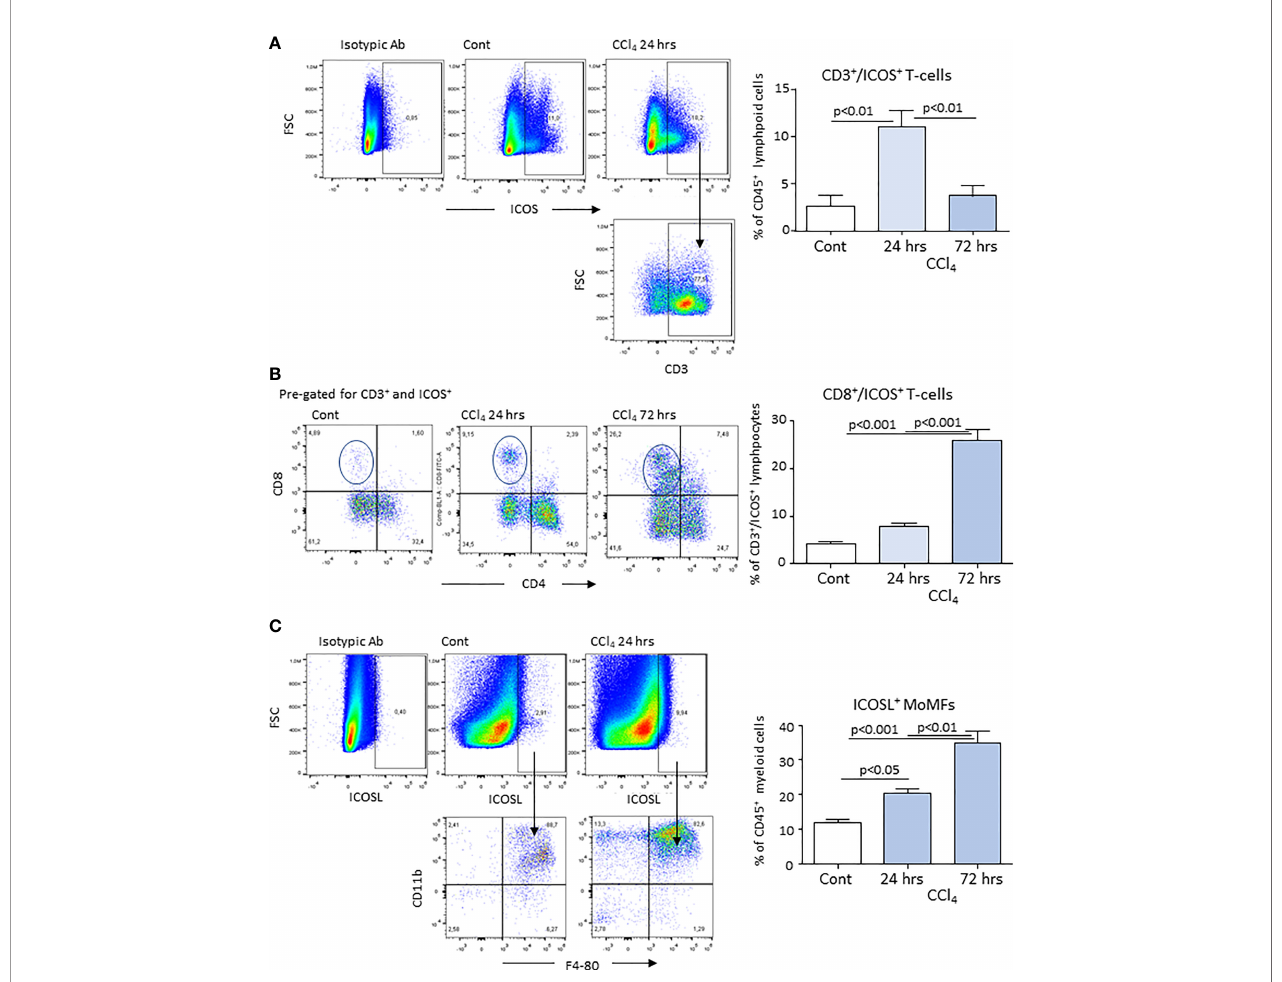
FIGURE 2 | Expression of ICOS and ICOSL by lymphocytes and monocyte-derived macrophages (MoMFs) in fi ltrating the liver during acute in fl ammation. Liver in fl ammation was induced in response to acute hepatocyte injury caused by carbon tetrachloride (CCl 4 ) in wild-type mice. The expression of ICOS was evaluated by fl ow cytometry in CD3 + T-lymphocytes in fi ltrating the liver of control (Cont) and CCl 4 -treated mice following 24 or 72 hours after challenge with the toxic agent (A) . Characterization of ICOS-expressing CD3 + /CD4 + helper and CD3 + /CD8 + cytotoxic T-cells in the liver of mice receiving CCl 4 for 72 hours (B) . Flow cytometry analysis of ICOSL expression among CD11b + /F4-80 + MoMFs (C) . The values are expressed as mean ± SD of 3-4 different cell